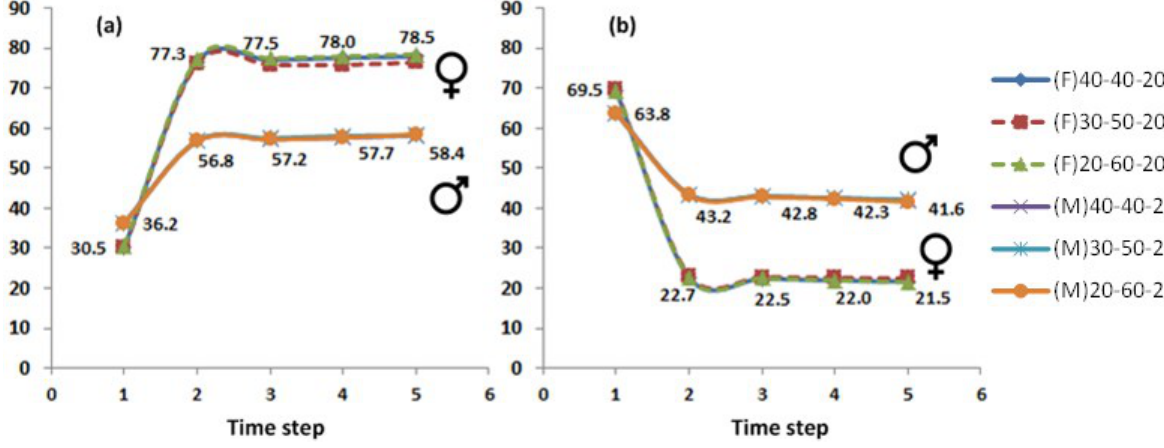
Figure 6. Annual percentages of households that applied manure ( a ) and chemical fertilizer ( b ) by gender of household head under different labor allocations and normal population growth (2.5%) .